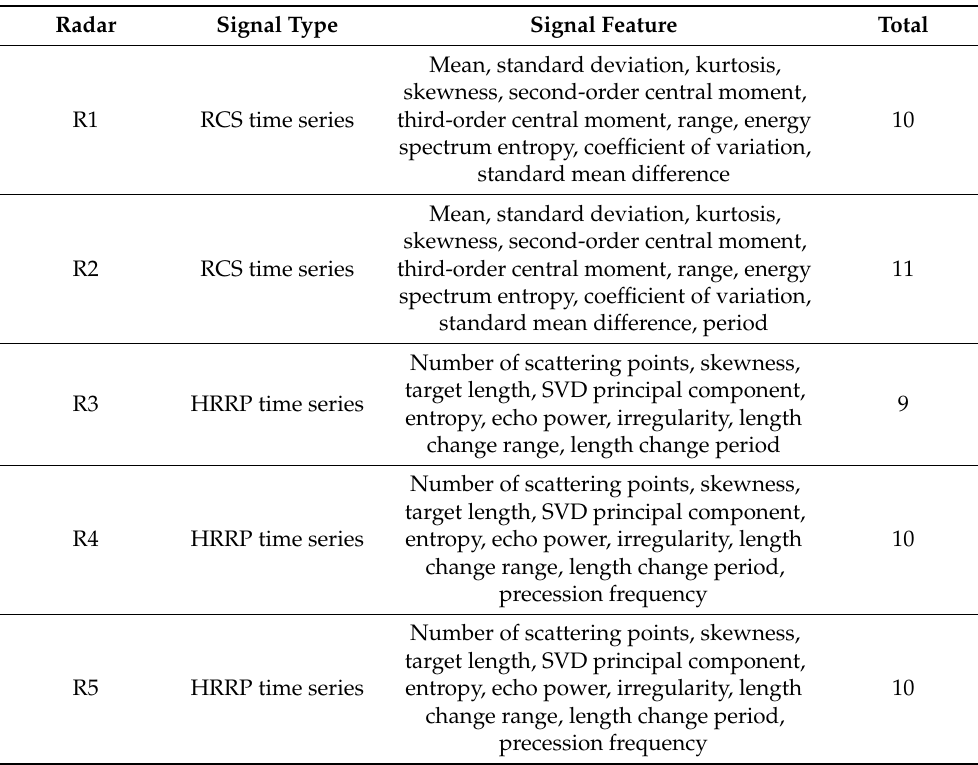
Table 3. List of radar signal